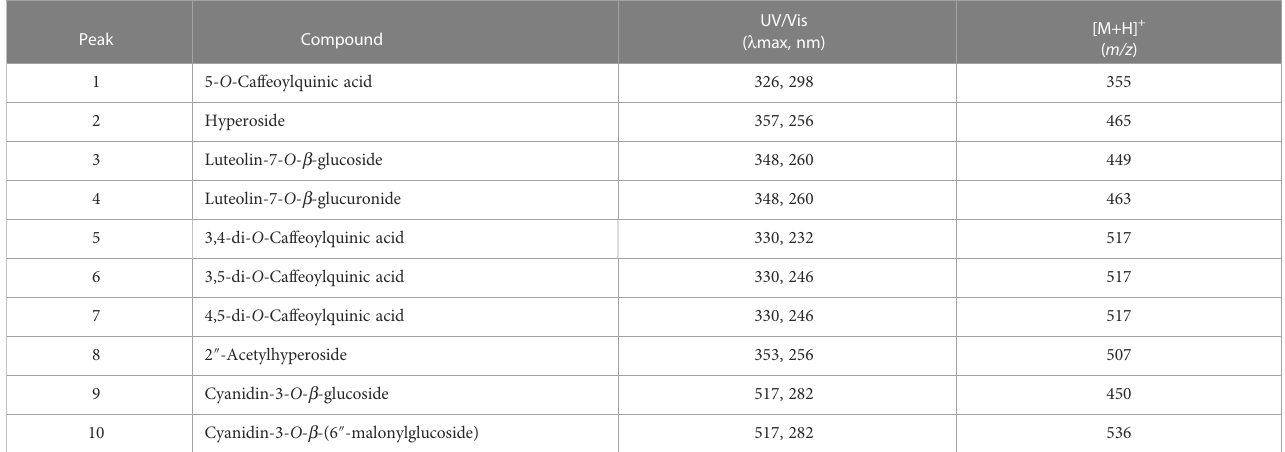
TABLE 1 UV/Vis and ESI/MS data of phenolic compounds in L. fi scheri leaves. Peak Compound